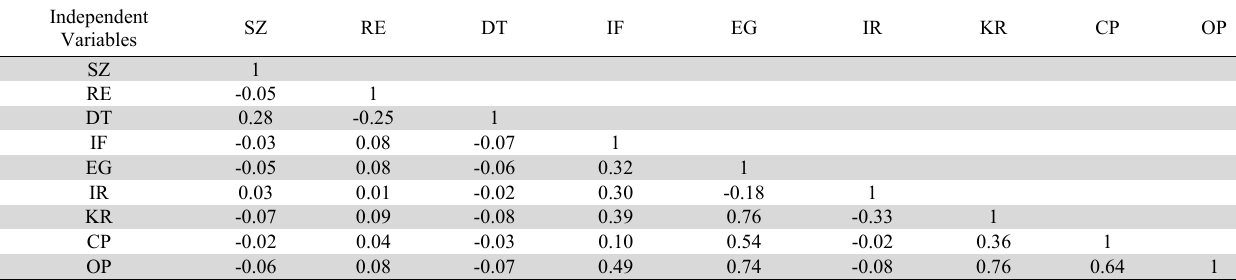
Correlation Matrix of macroeconomic and raw material Variables Independent Variables